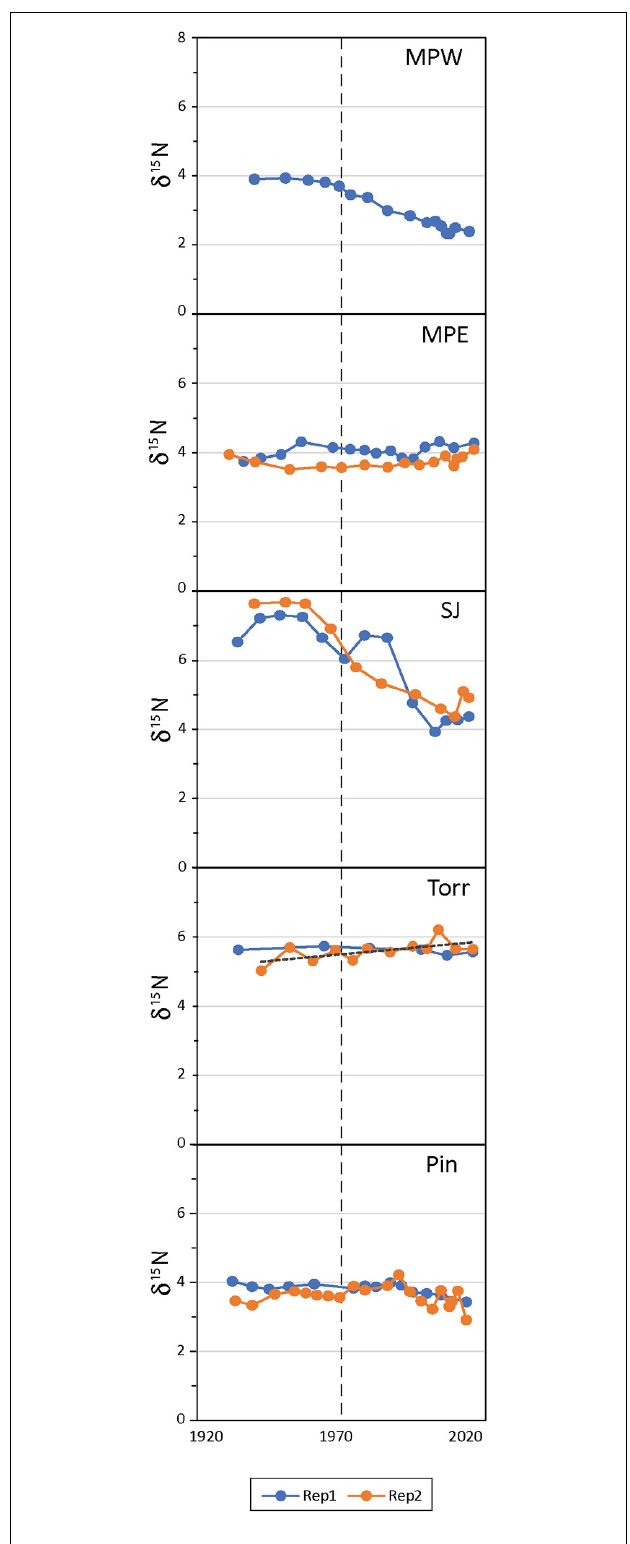
FIGURE 3 | Mangrove soil bi-plot of sediment δ 15 N vs. time in radiometrically-dated mangrove cores (see Table 1 for site abbreviations; all sites had 2 core replicates except